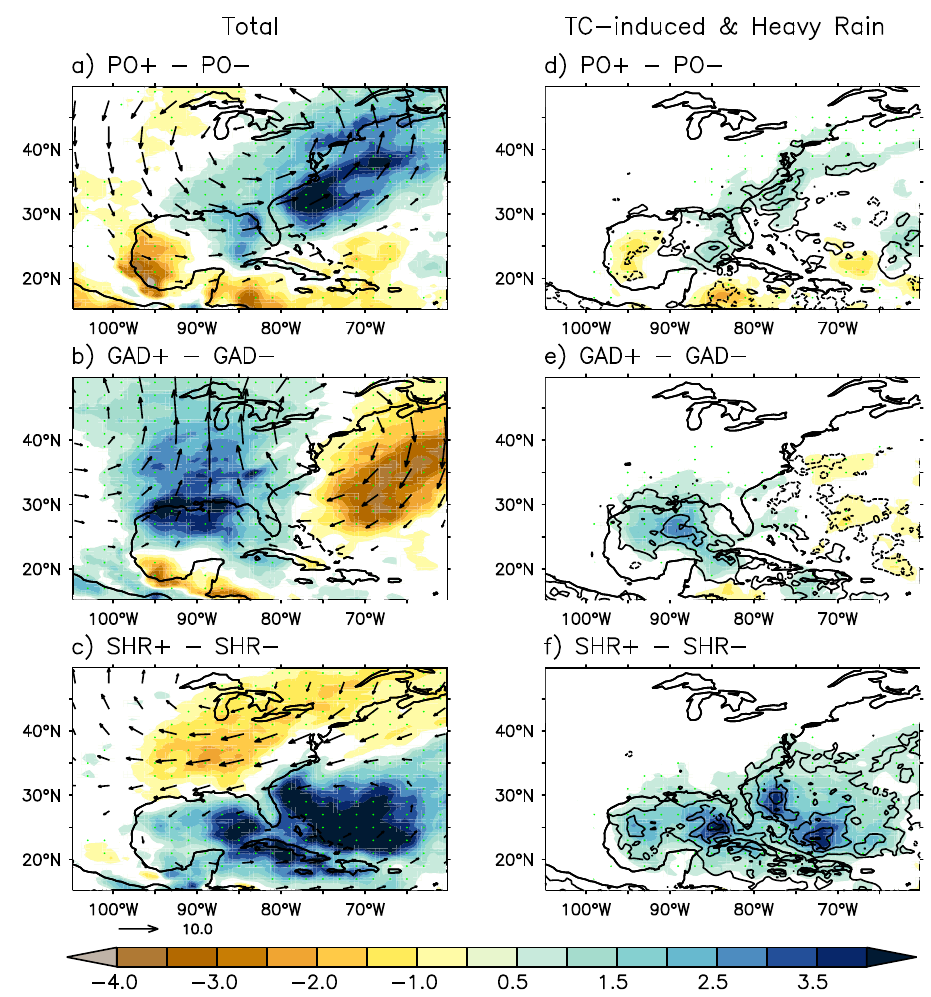
between the strong positive (PC > 1) and negative (PC < − 1) phases of these three modes. d – f Similar to the a – c but for TC-induced precipitation only (shading) and the heavy precipitation anomalies (contours with interval of 1 mm per day). The green stippling denotes the regions with composites that are signi fi cant at the 5% level for precipitation anomalies (left panel) and the TC-induced precipitation (right